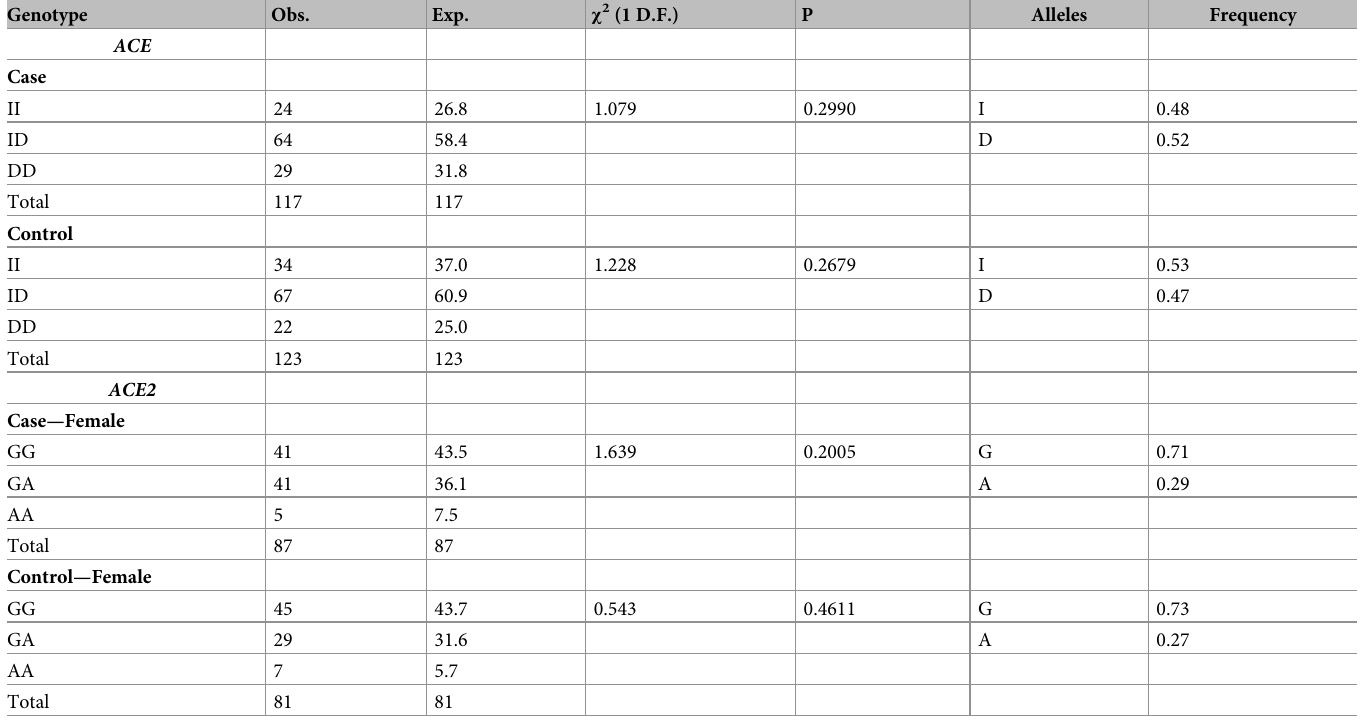
Table 4. Test for Hardy-Weinberg equilibrium for ACE I/D and ACE2 G8790A polymorphisms on case (SAH patients) and control groups. Genotype Obs.